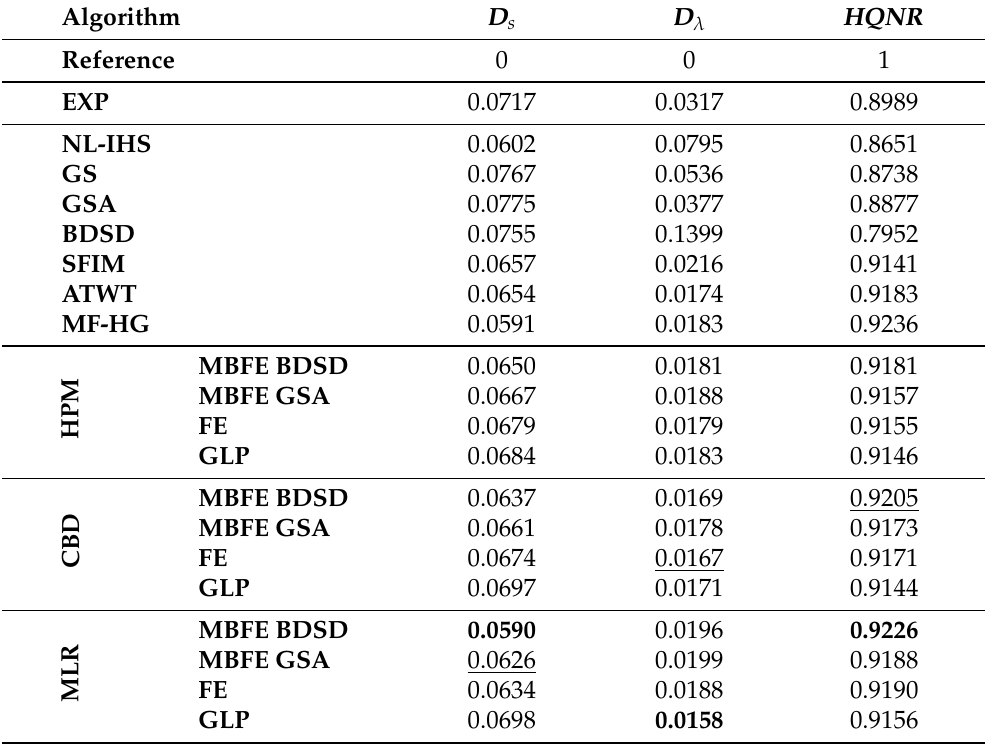
Table 2. Full resolution assessment on the Tripoli dataset: the first row contains the reference for each indicator. Best results for the two tested injection schemes (HPM and CBD) are in boldface; the second best are